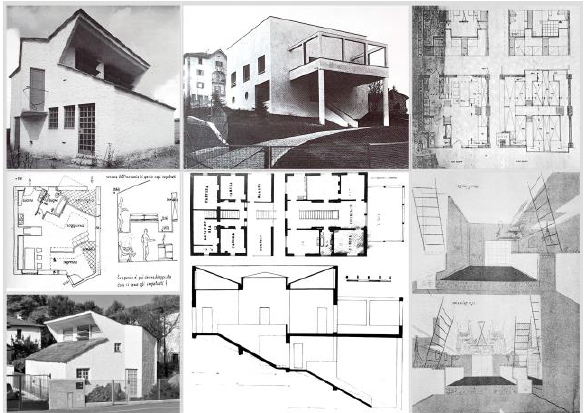
Figure 3. Design references: the 1947 ‘minimum house’ (left), the 1932 Villa Ardiani in Selvino (middle), the 1945 project for the Banca Popolare di Bergamo’s building initiatives